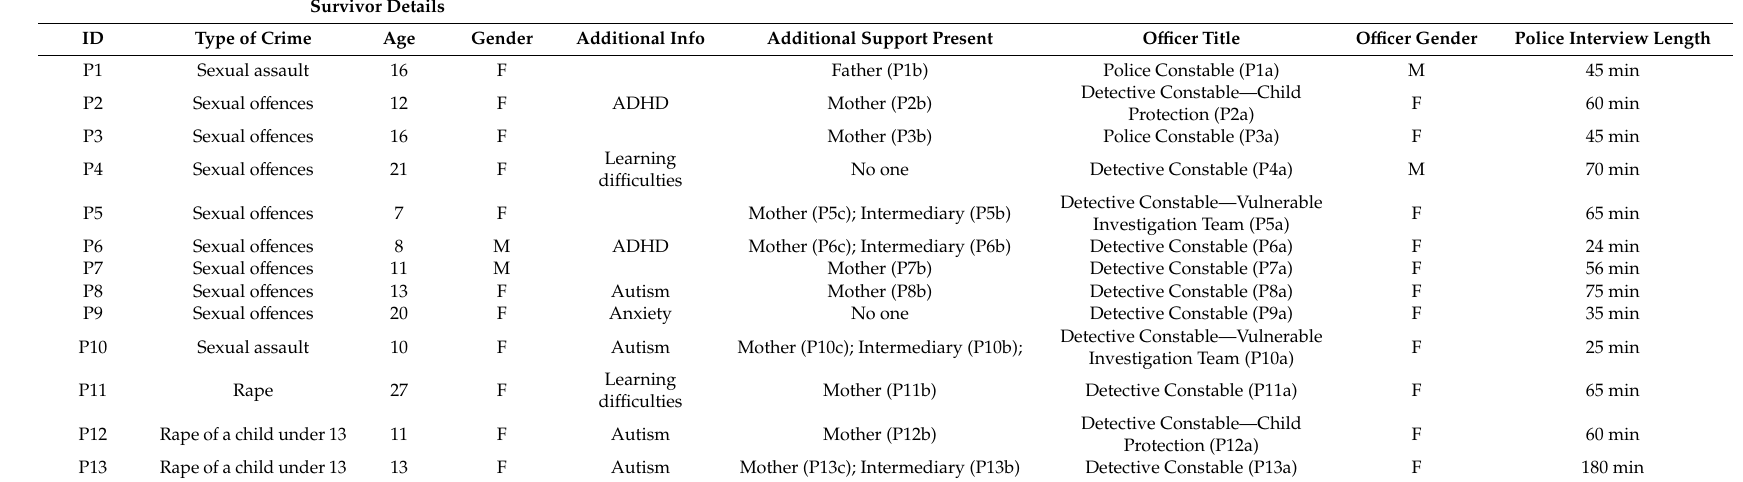
Table 1. Overview of each case including type of crime, survivor demographics, and who was present on the day of the police interview. Survivor